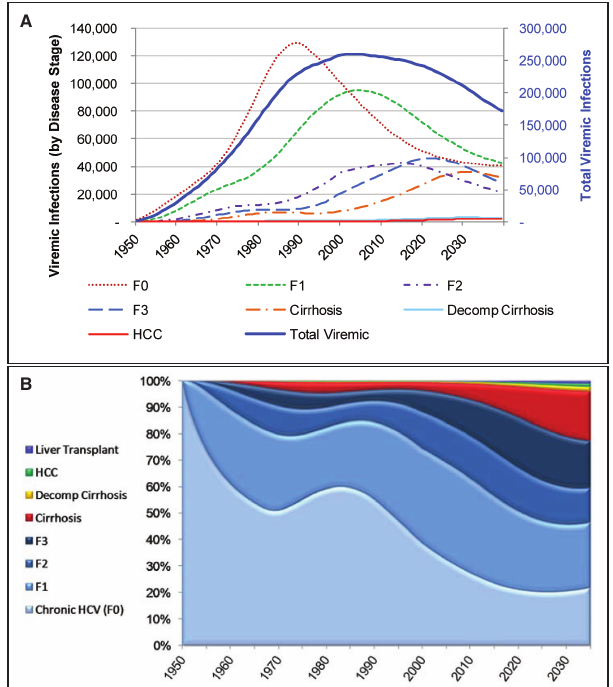
Figure 5) A Number of viremic hepatitis C (HCV) cases, in total and according to disease stage. B Proportion of all viremic HCV cases according to disease stage, 1950 to 2035. Decomp Decompensated; F Fibrosis stage; HCC Hepatocellular carcinoma TAble 4 estimated future lifetime cost according to disease state for men 35 to 39 years of age with hepatitis C